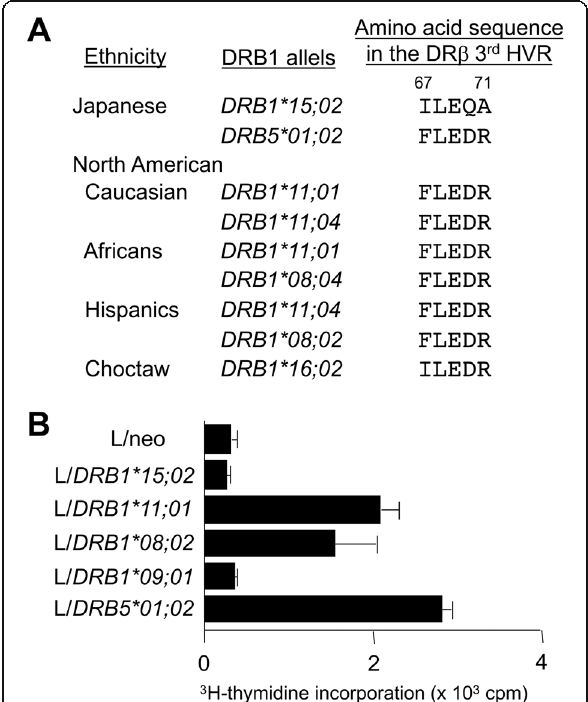
Fig. 1 A DRB1 or DRB5 alleles associated with the presence of anti- topo I antibody in various ethnicities and their amino acid sequence at positions 67 – 71 in the third hypervariable region (HVR).